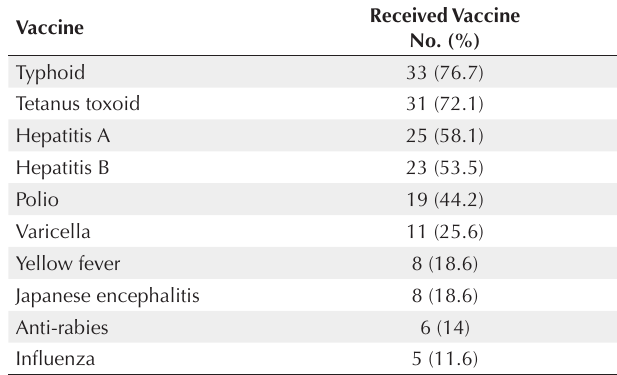
Table 3. Vaccines Received by Participants Prior to Travel (n = 43)